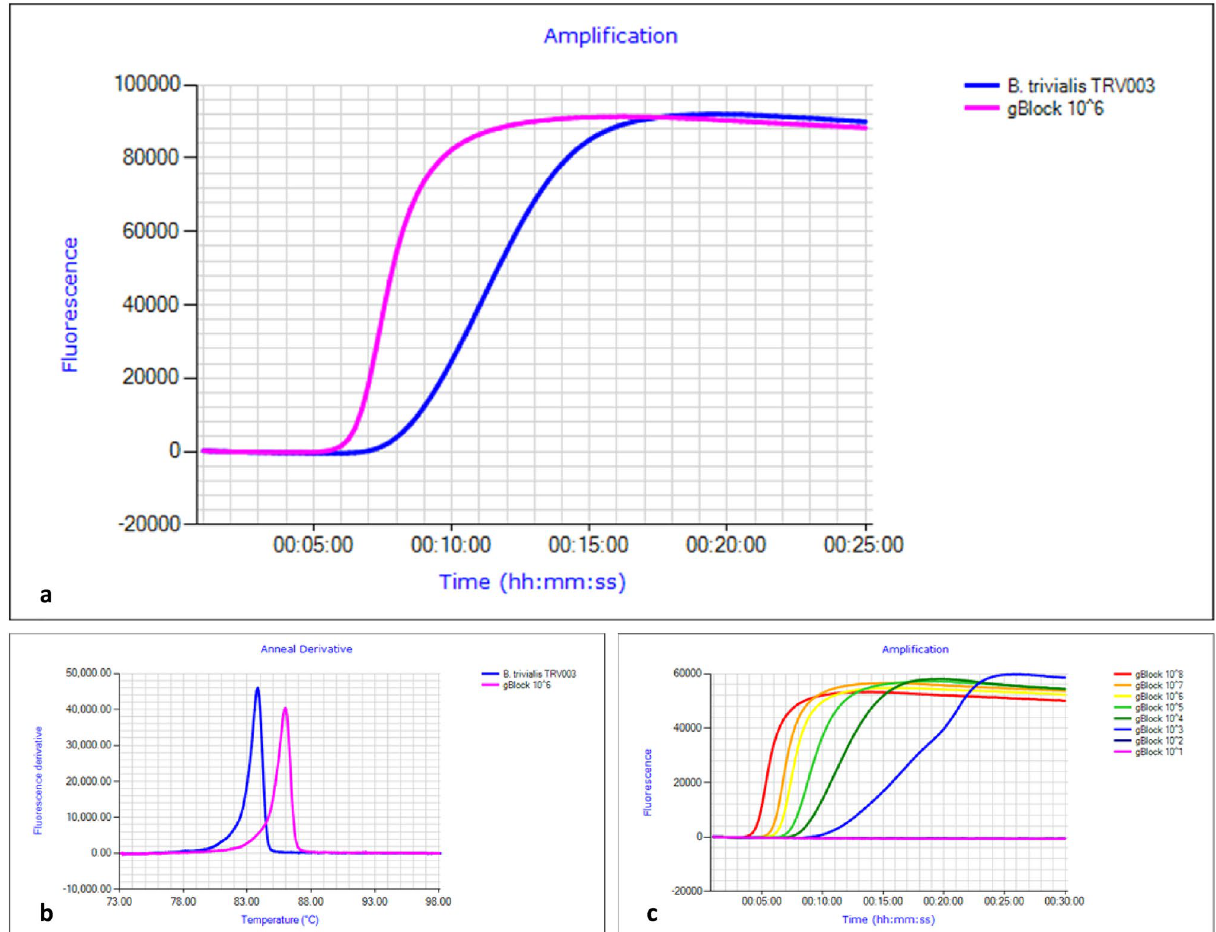
Figure 2. ( a ) Comparison of amplification of gBlock positive control and Bactrocera trivialis TRV003 DNA in the BtrivEIF3L LAMP assay. ( b ) Anneal derivative of gBlock positive control and Bactrocera trivialis TRV003 DNA in the BtrivEIF3L LAMP assay; in this LAMP run the gBlock positive anneals at ~ 86 °C, while B. trivialis DNA anneals at ~ 84 °C. The gBlock 1 × 10 6 copies/µL is the appropriate concentration for use as a control. ( c ) BtrivEIF3L assay gBlock standard curve run with serial dilutions from 1 × 10 8 copies/µL to 1 × 10 1